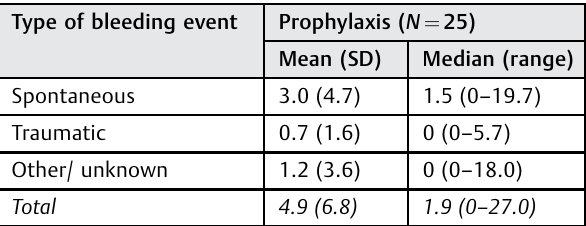
Table 4 Annualized bleeding rates in the prophylaxis population